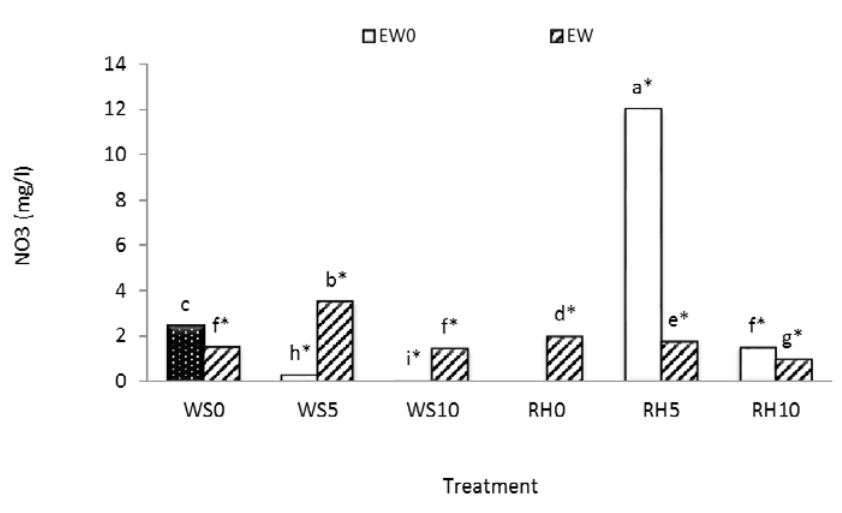
in the Wastewater Figure 5. Effects of the treatments on the Concentration of NO 3 EW0: without vermicomposting; EW: with vermicomposting; WS0: without wheat straw; WS5: 5% v/v wheat straw; WS10: 10% v/v wheat straw; RH0: without rice husk; RH5: 5% v/v rice husk; RH10: 10% v/v rice husk. Means in the same column followed by the same letter are not significantly different according to DMRT at